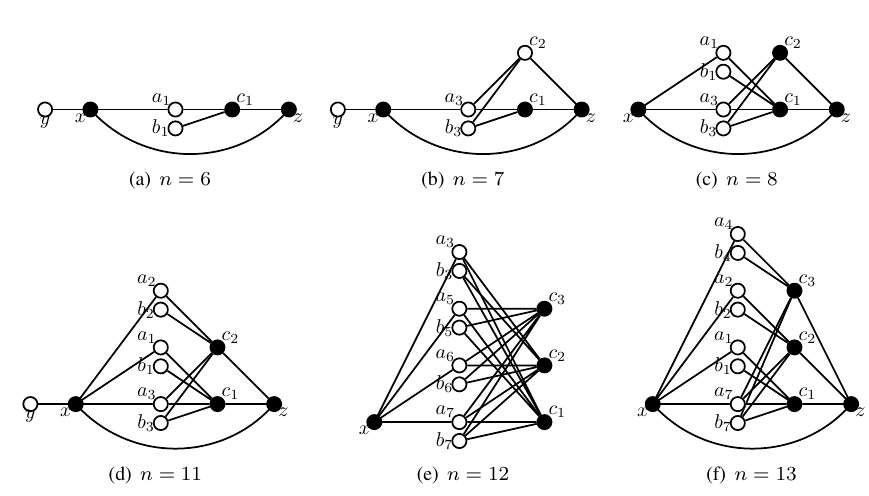
Fig. 4: Bipartite graphs G such that γ ( G x ) − γ ( G ) is maximal within these bipartite graphs. The maximality of Constructions 4(a), 4(d) and 4(f) follows from Theorem 4. The maximality of Constructions 4(c) and 4(b) and 4(e) follows from Remarks 5 and 6. The black dots are an identifying code of G . The vertices a i , c j , x and y are an optimal identifying code of G x